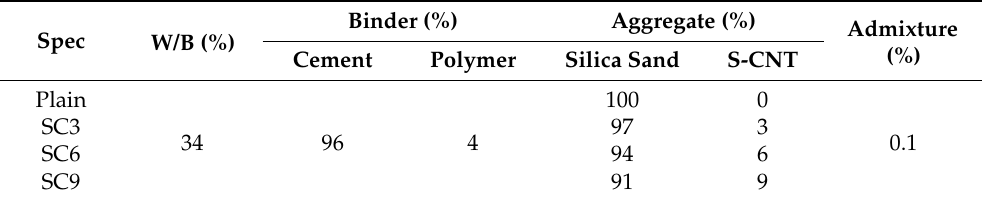
Table 4. Mixture proportions (mass